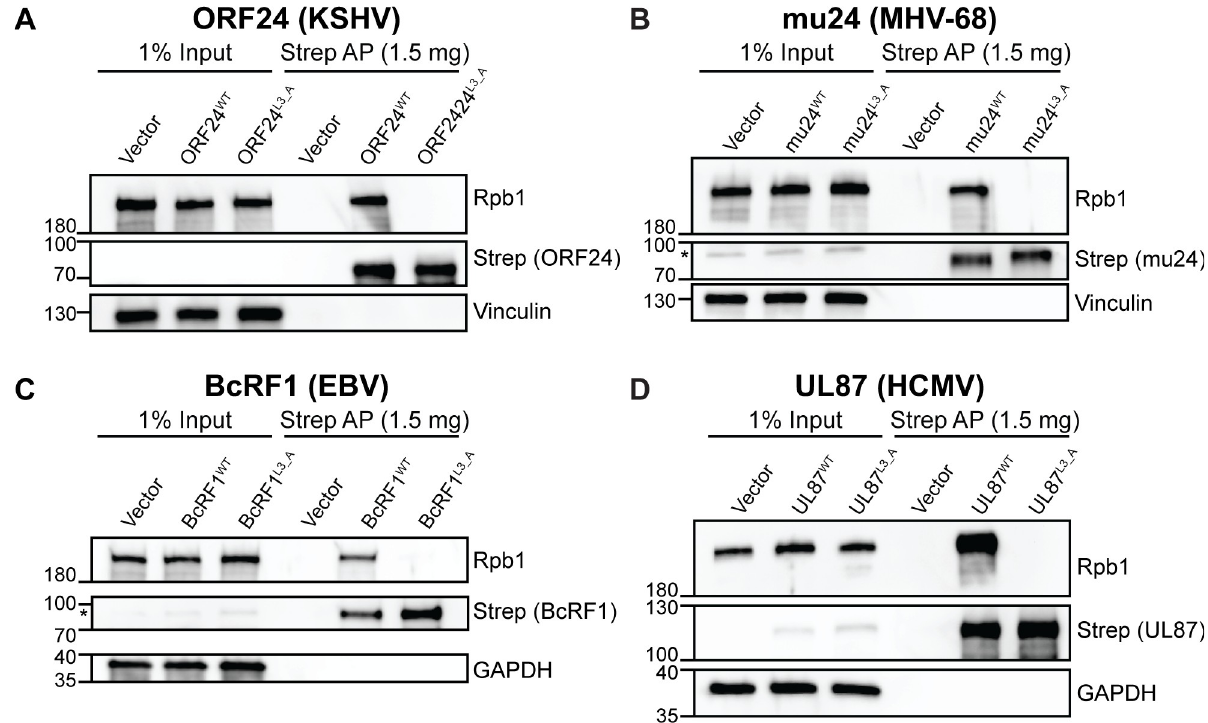
Fig 1. The RLLLG motif in ORF24 homologs from other β - and γ -herpesviruses is required for interaction with Pol II. Full-length WT or 3L_A mutants, which mutates the conserved RLLLG motif, of Strep-tagged ORF24 (A) or homologs from MHV68 (mu24) (B), EBV (BcRF1) (C), and HCMV (UL87) (D) were transiently transfected into HEK293T cells then co-affinity purified (AP) with StrepTactinXT beads followed by western blotting. ( � ) indicates the presence of a non-specific band seen while using the anti-Strep antibody.